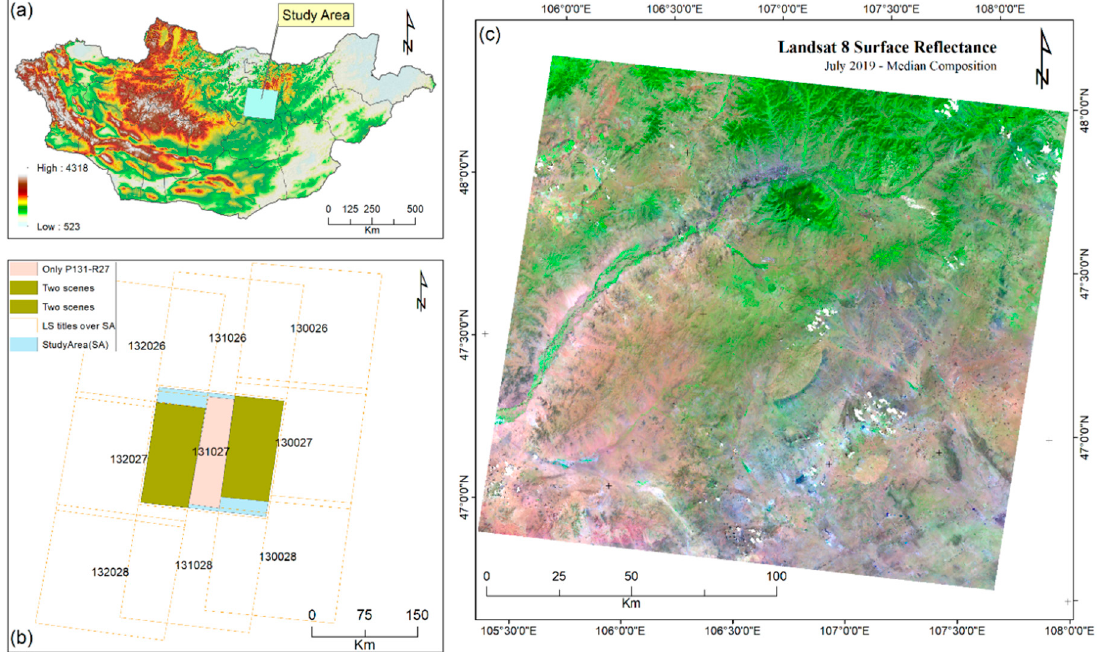
e ff ect of di ff erent composition methods (i.e., median metric versus single date image or time series image data).